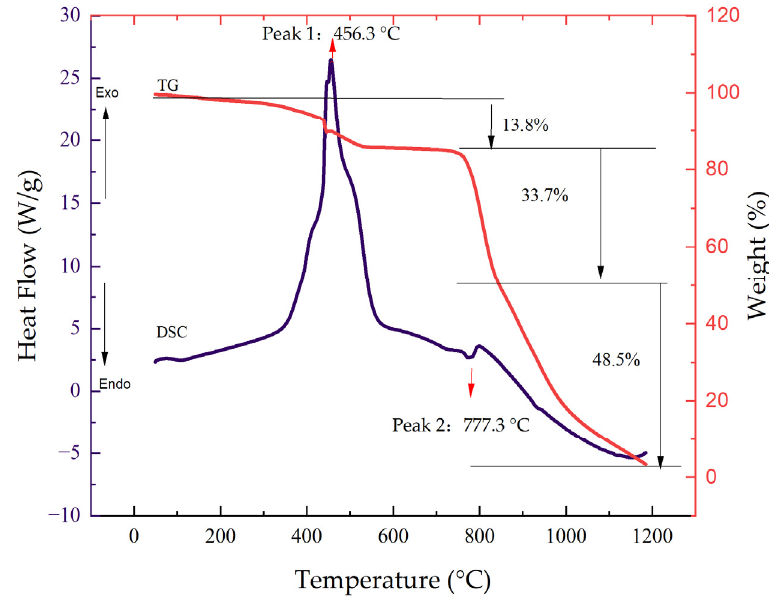
Figure 3. TG/DSC curve of molybdenum sulfide pyrolysis.